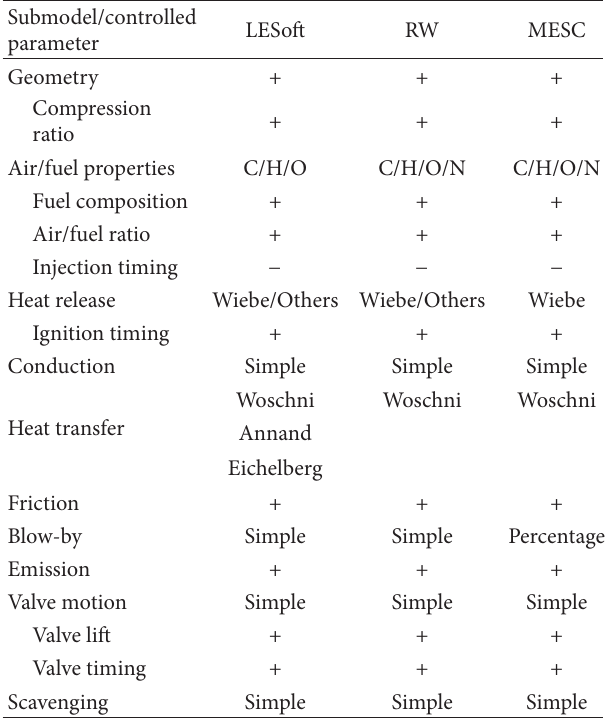
Table 1: Capability of engine simulation